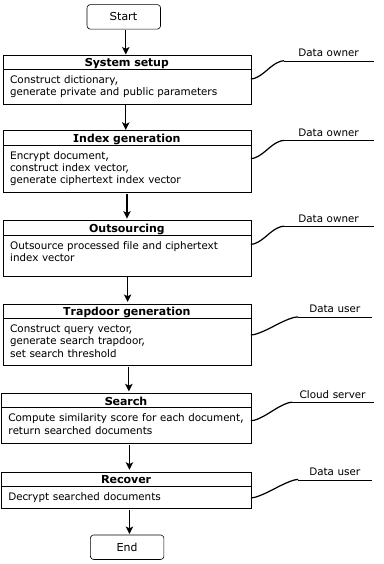
Figure 3. The flow chart of basic PRMS